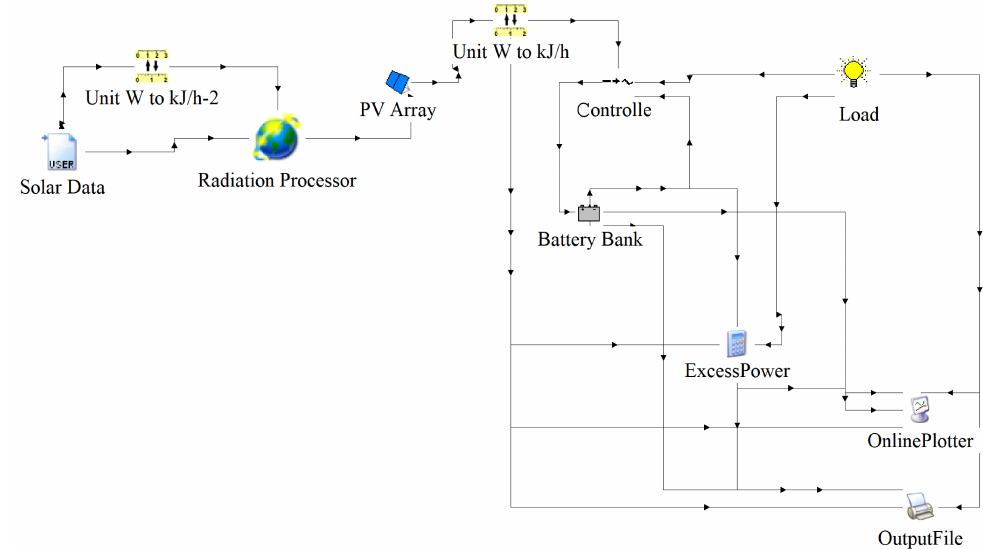
Figure 2. TRNSYS model of the health center PV system.